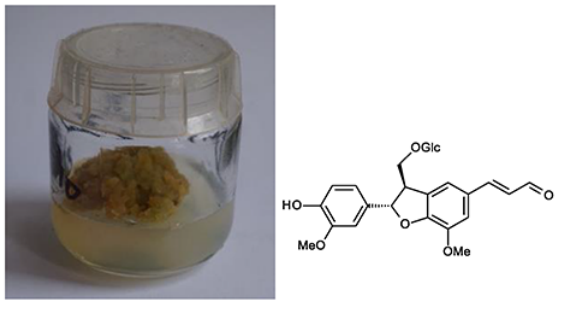
Figure 21 Chemical structure of (+)-balanophonin-9- O